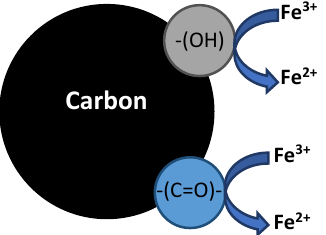
Figure 4. Effect of the addition of carbon in the promoted reduction of Fe 3+ to Fe 2 [104].